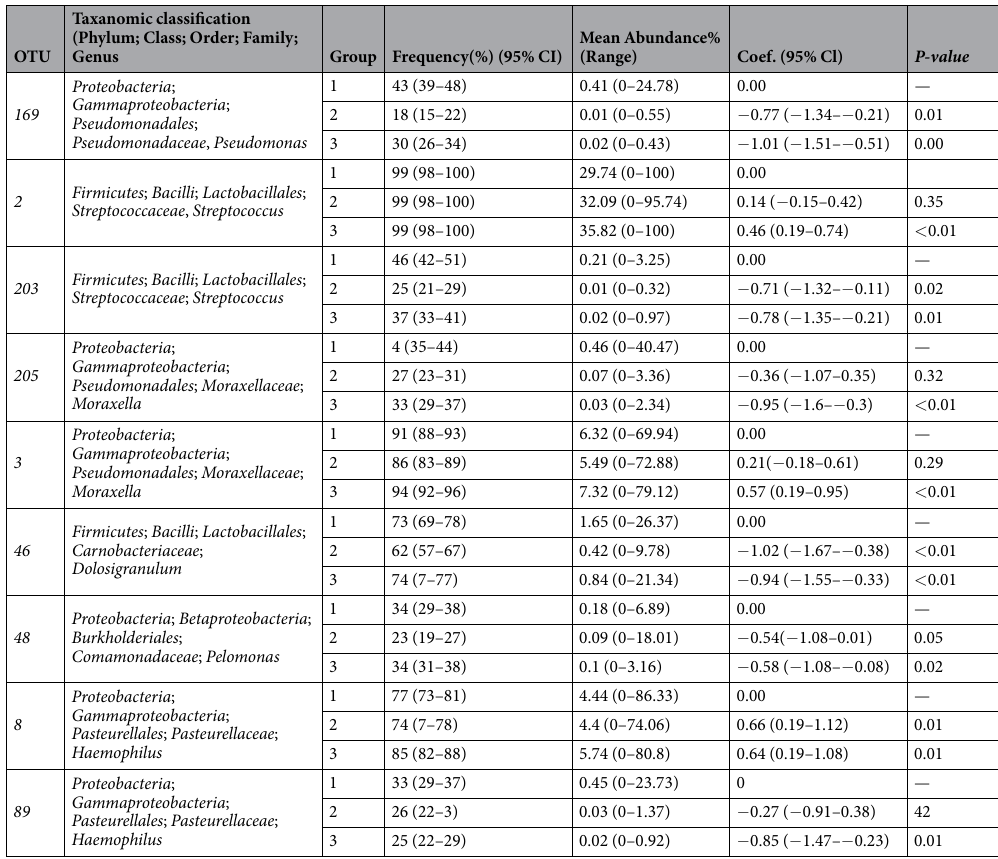
Table 2. OTUs with differential abundance by vaccination group in the first year of life. The mixed effect random intercept model was adjusted for time-invariant explanatory variables (gender, place of birth,